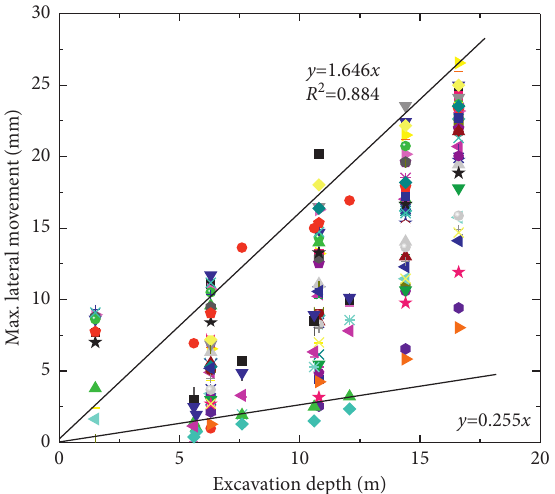
up at the retaining